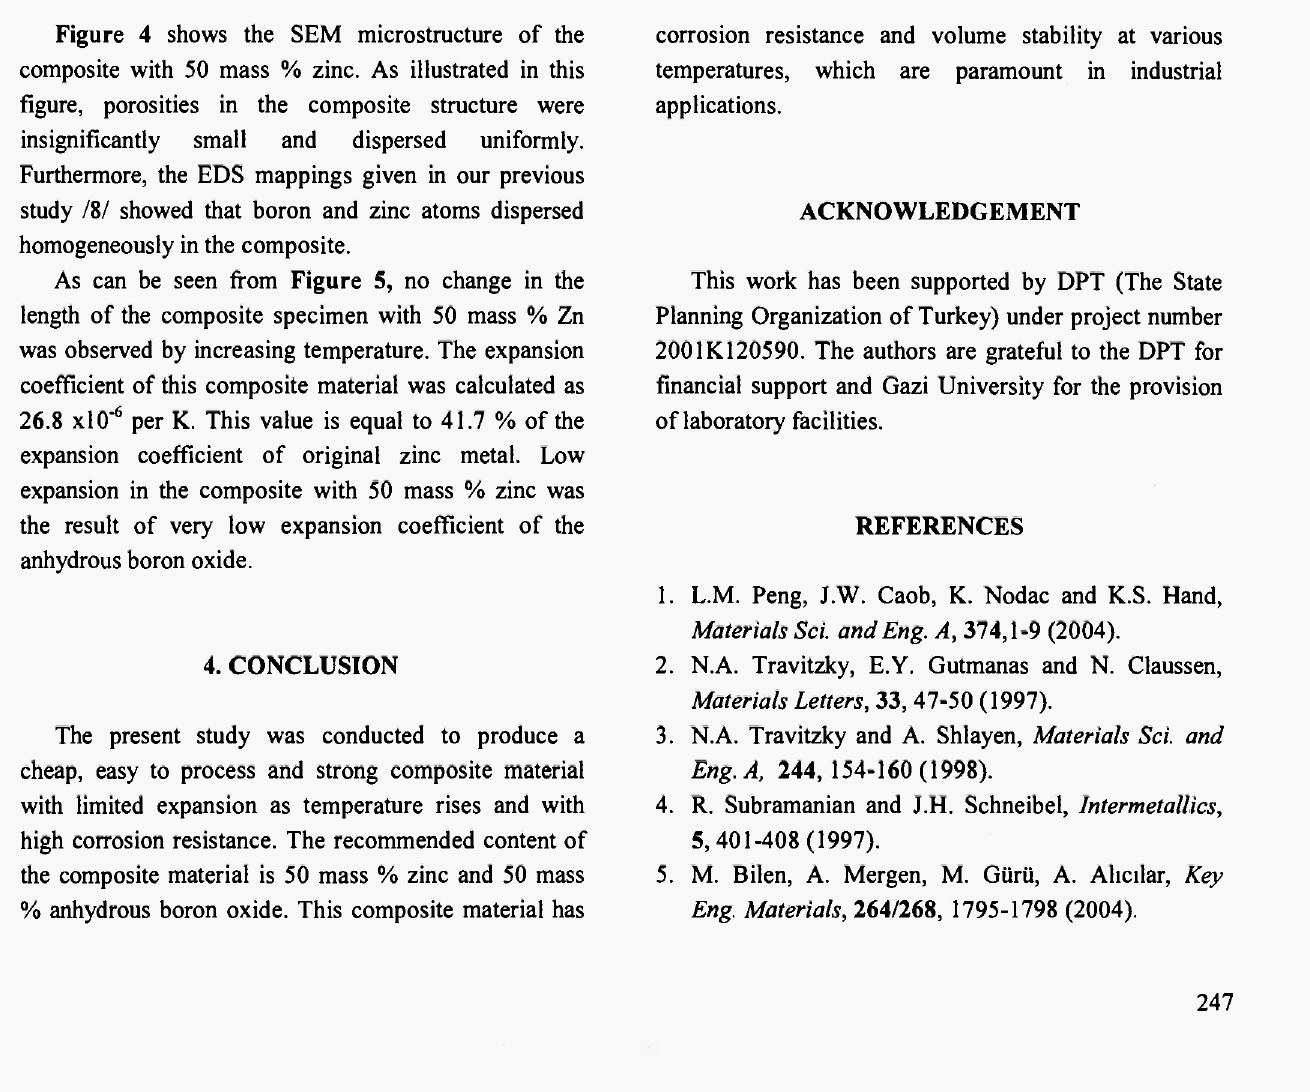
Fig. 5: The variation of the specimen length with temperature for the composite with 50 mass % zinc.